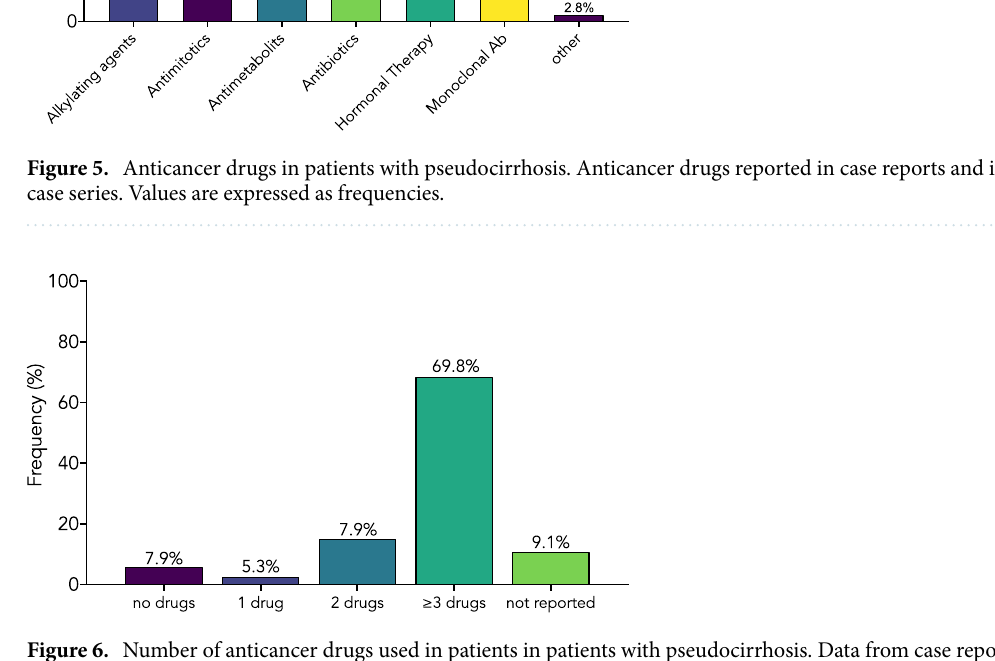
Figure 6. Number of anticancer drugs used in patients in patients with pseudocirrhosis. Data from case reports and case series. Values are expressed as